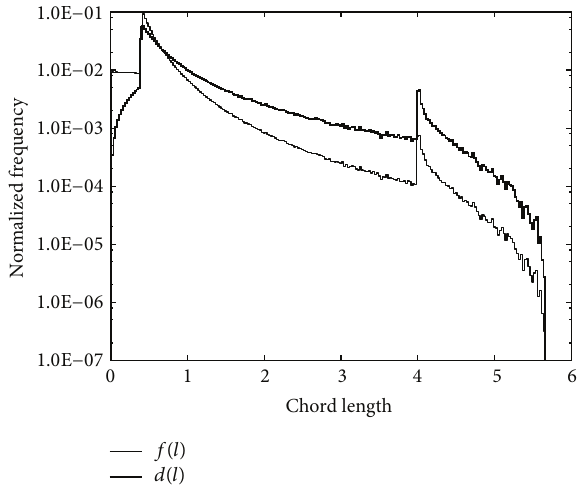
Figure 4: 𝑓(𝑙) and 𝑑(𝑙) distributions for a rectangular parallelepiped with relative dimensions 4 × 4 × 0.4